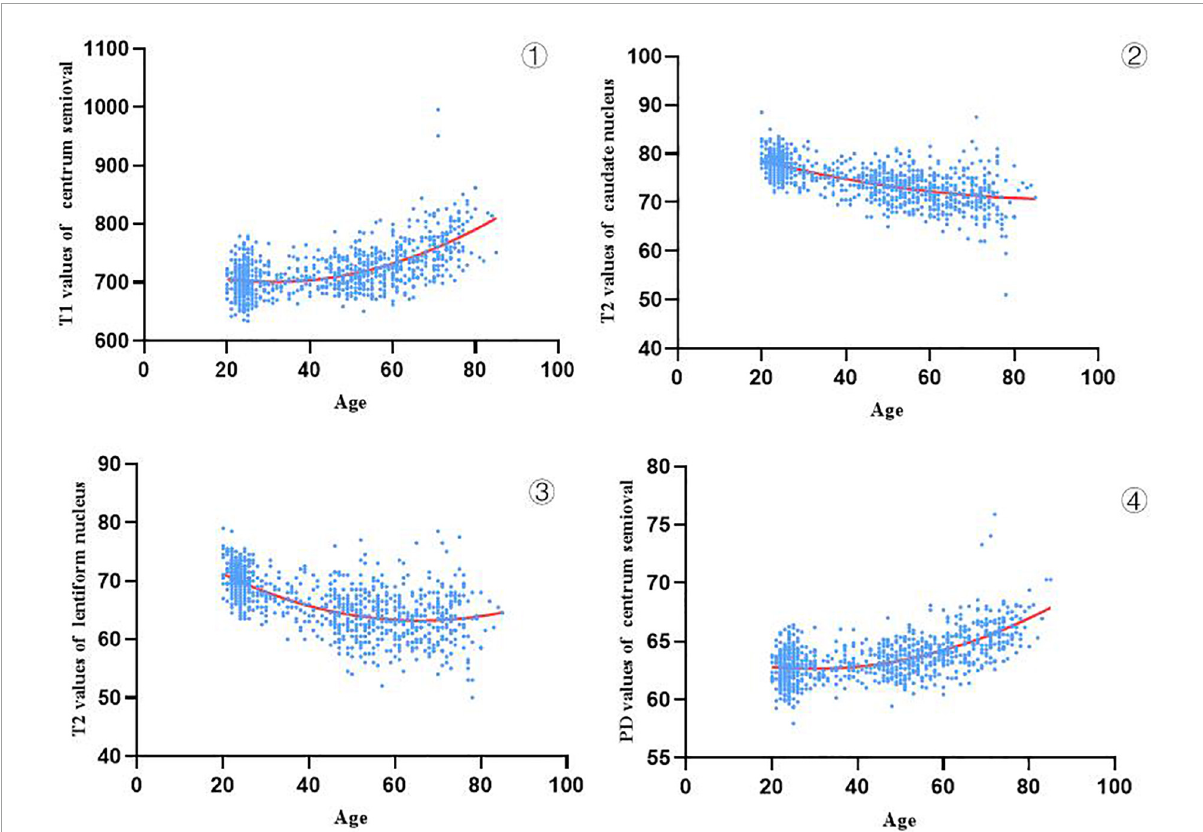
FIGURE4 Trajectories of T1, T2 and PD values in age-related brain regions (943 subjects) (cid:172) show that the T1 values of the centrum semiovale increased with age, (cid:173) , (cid:174) show that the T2 values of the caudate nucleus and lentiform nucleus decreased with age, and (cid:175) show that the PD values of centrum semiovale increased with